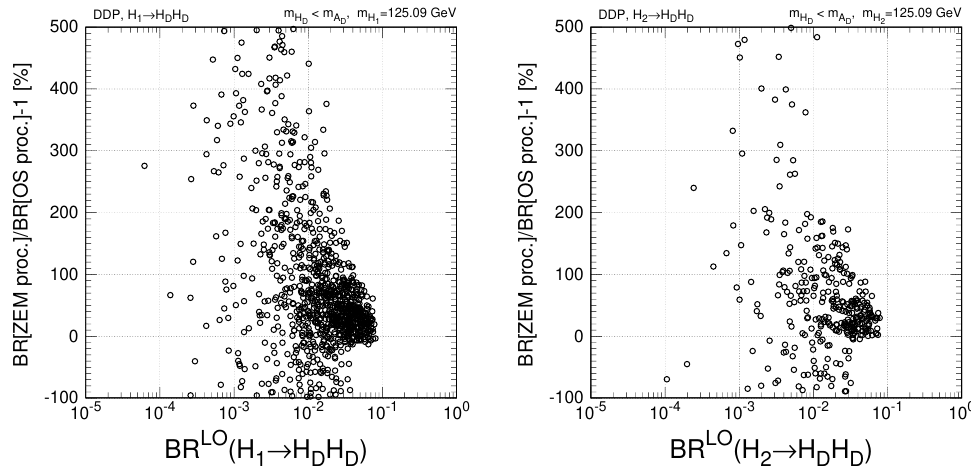
Figure 8 . Comparison of the two process-dependent renormalization schemes, on-shell vs. zero external momenta. We show the ratio between the NLO values vs. the corresponding BR( H H D H D ) (left) and BR( H 2 → H D H D ) (right) at LO.